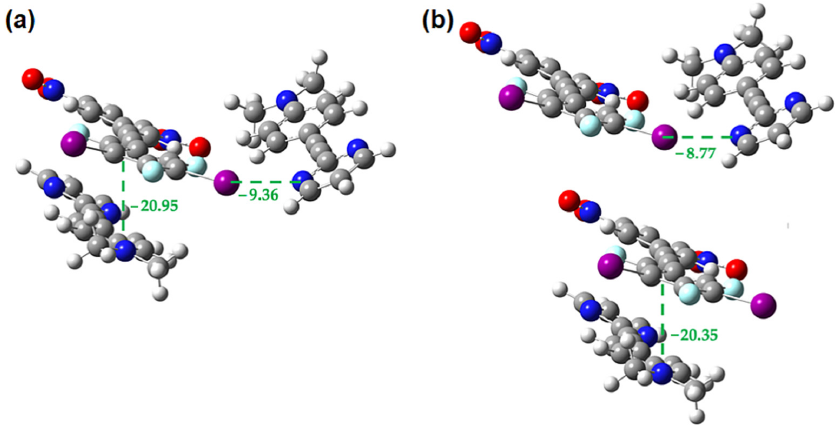
Figure 20. M062X-D3/DGDZVP interaction energies (in kcal/mol) in the 2 • 3 cocrystal for the interplay between the face-to-face 2-3 π -stacking and the bent halogen bond ( a ) within trimer ( b ) in the isolated dimers.